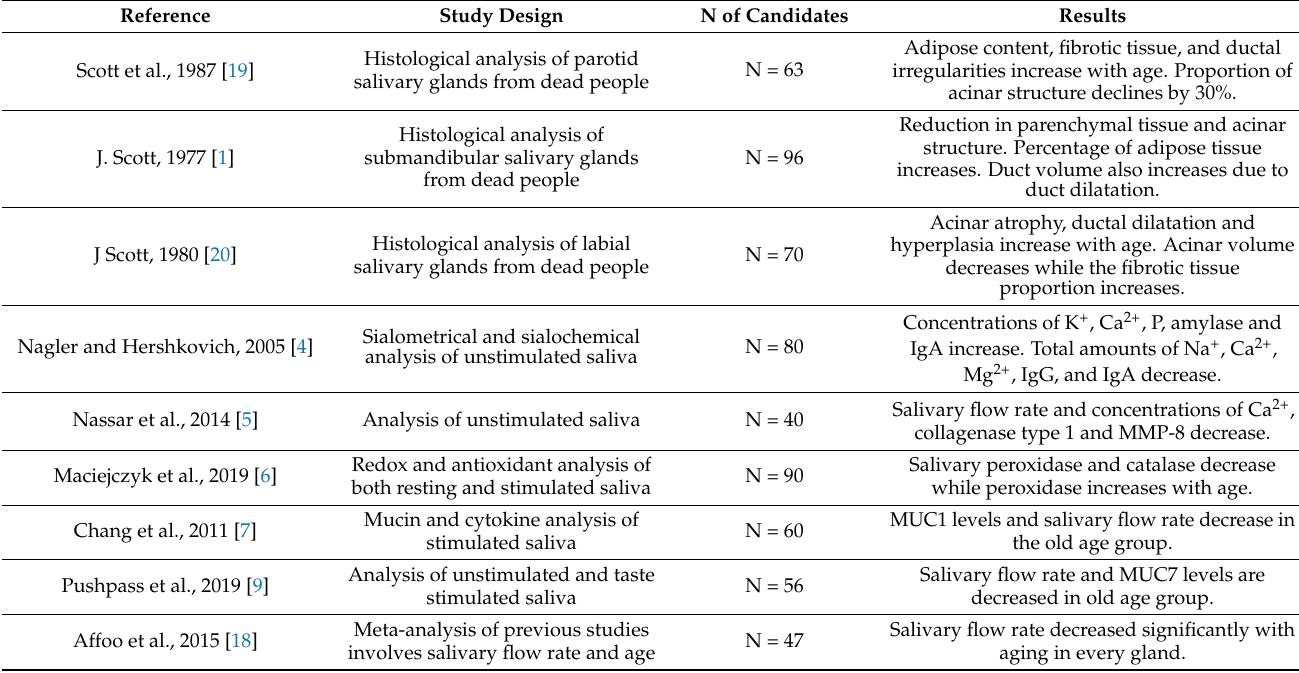
Table 1. Aging-induced histological alteration, change in saliva composition, and salivary flow